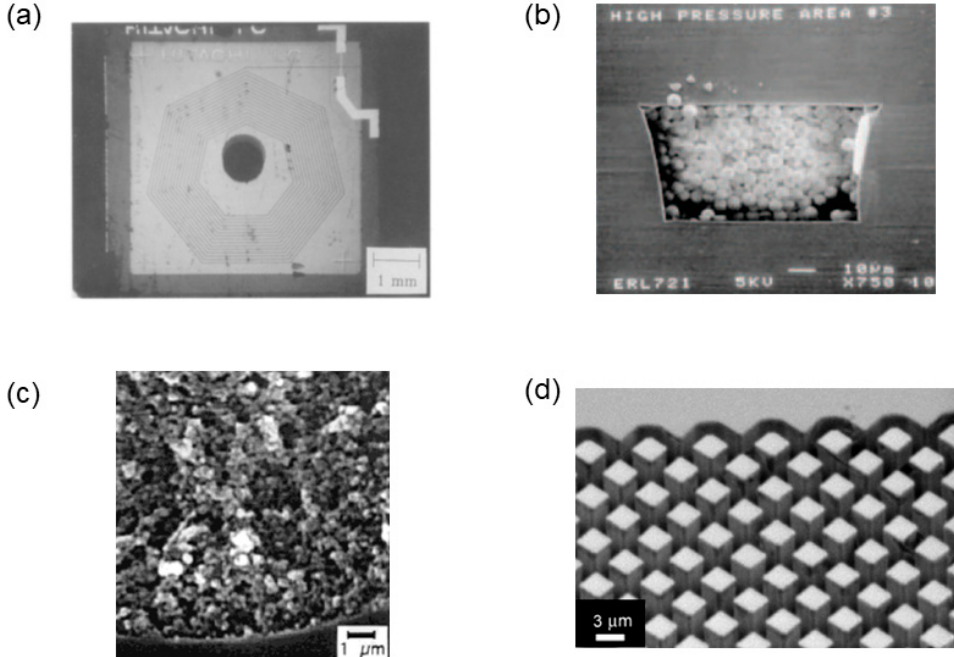
Figure 1. Four approaches for on-chip LC: use of ( a ) open-tubular [1], ( b ) packed-particle [2], ( c ) monolithic [3], and ( d ) pillar array columns [4]. Reproduced with permission from references.